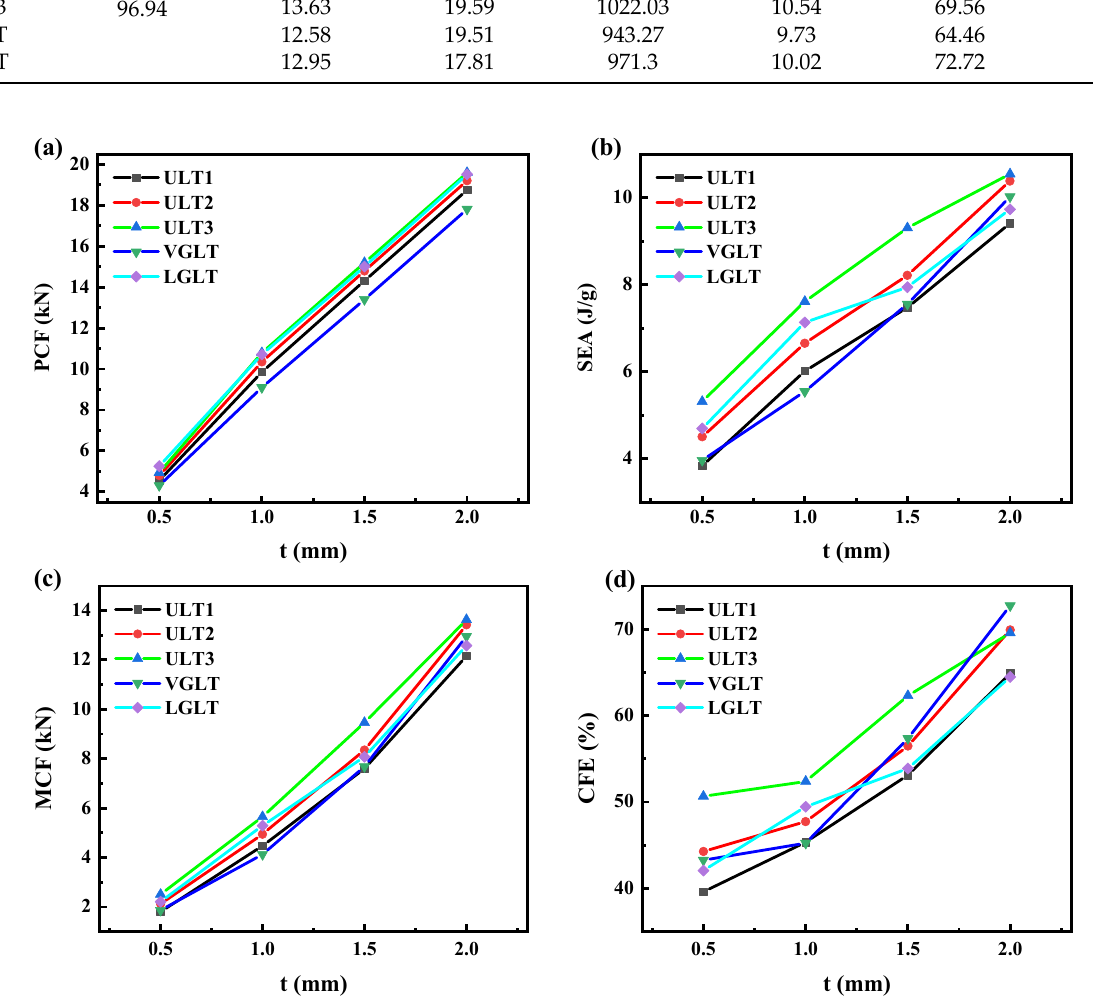
Figure 15. Effect of wall thickness on impact resistance of hybrid structures ( a ) PCF; ( b ) SEA; ( c ) MCF; and ( d ) CFE.